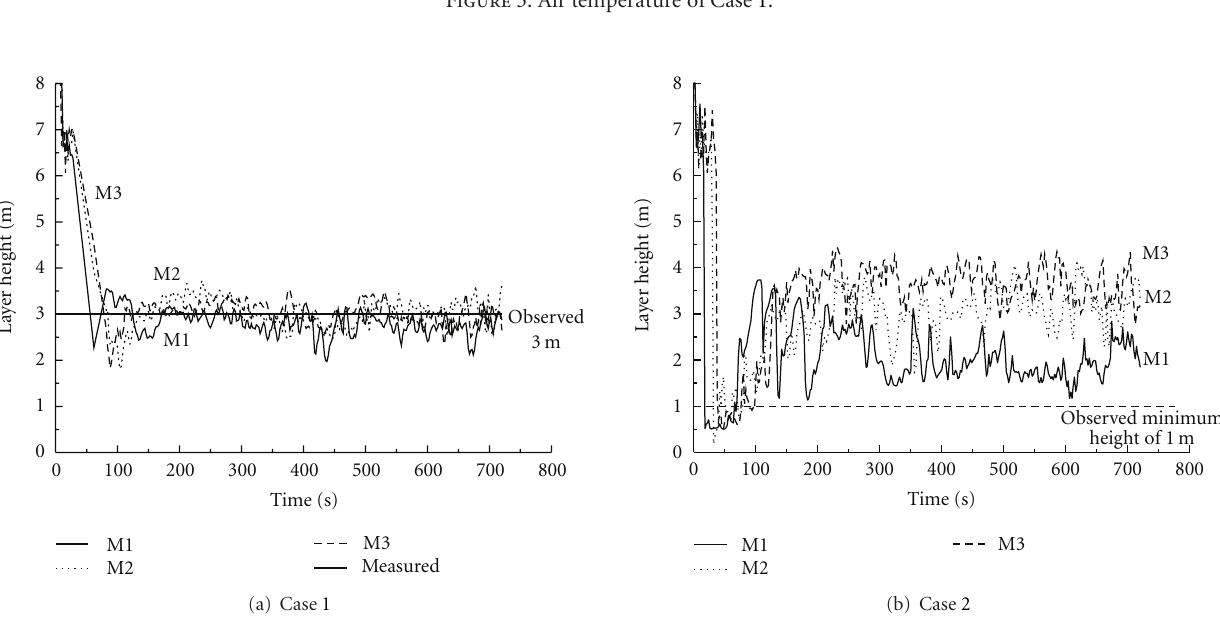
Figure 3: Air temperature of Case 1.